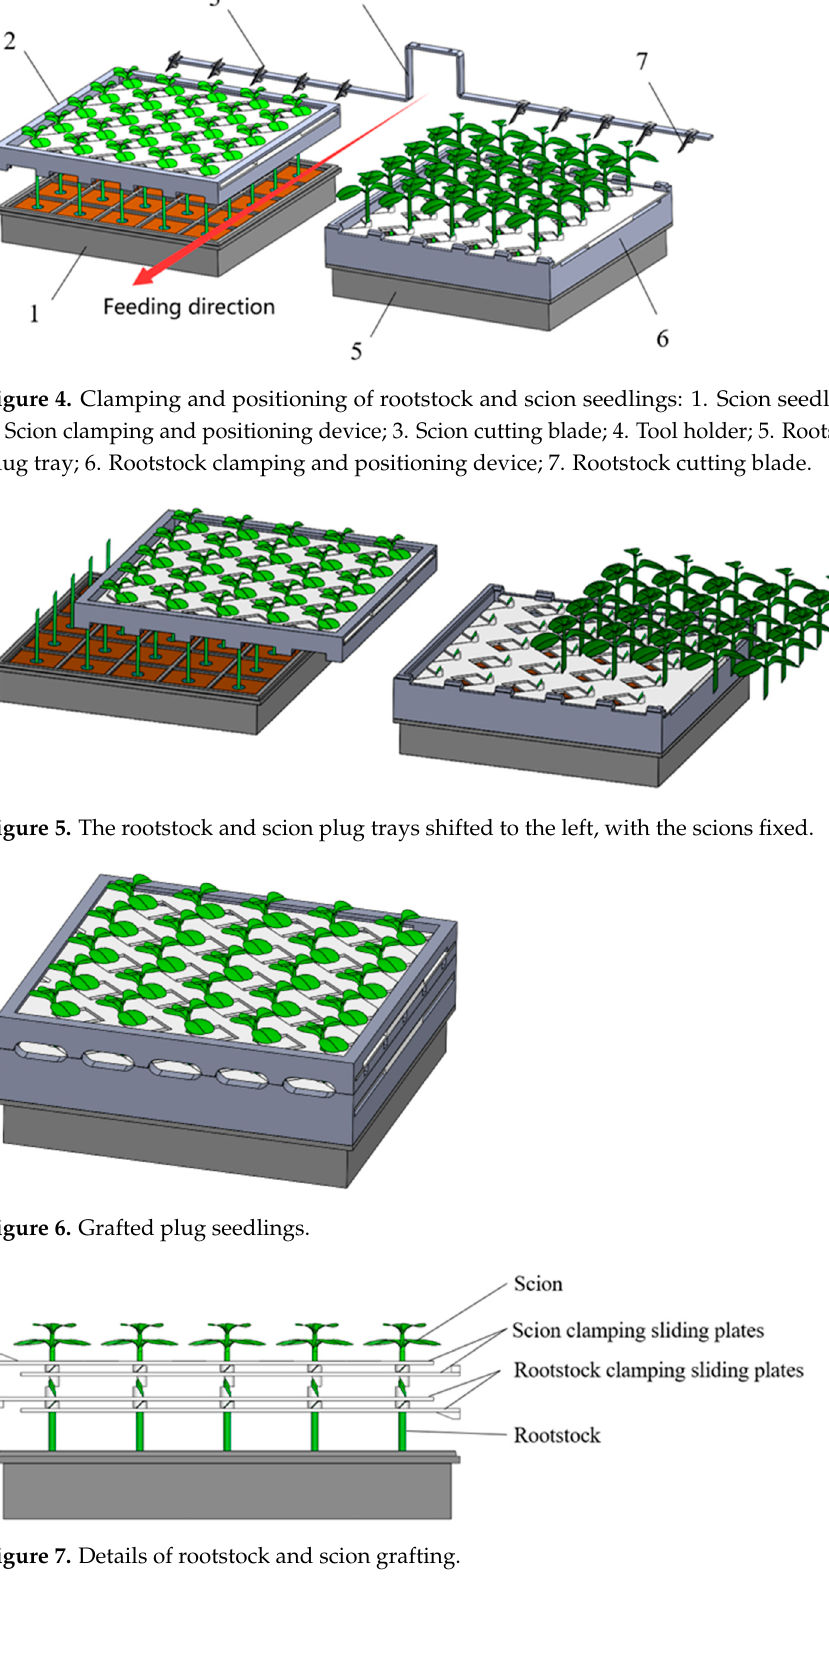
Figure 4. Clamping and positioning of rootstock and scion seedlings: 1. Scion seedling plug tray; 2. Scion clamping and positioning device; 3. Scion cutting blade; 4. Tool holder; 5. Rootstock seedling